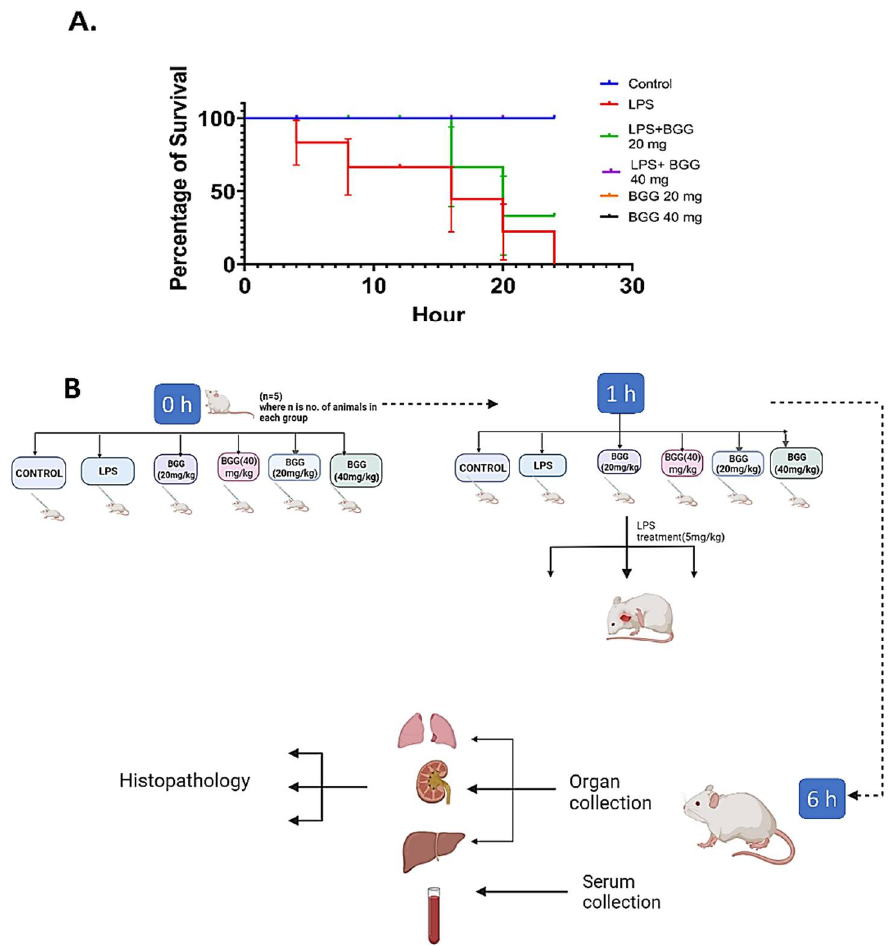
Figure 14. Representation of the BGG protection on LPS-induced sepsis model in mice. ( A ) Animal survival data. ( B ) Flow charts depict the LPS-induced sepsis model in mice.